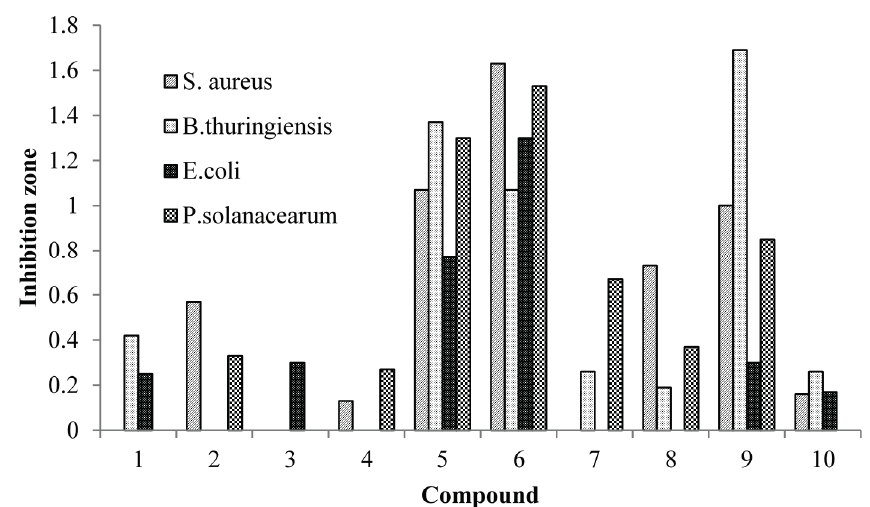
Figure 4. Antibacterial activities of the compounds isolated from the leaves of Indocalamus latifolius